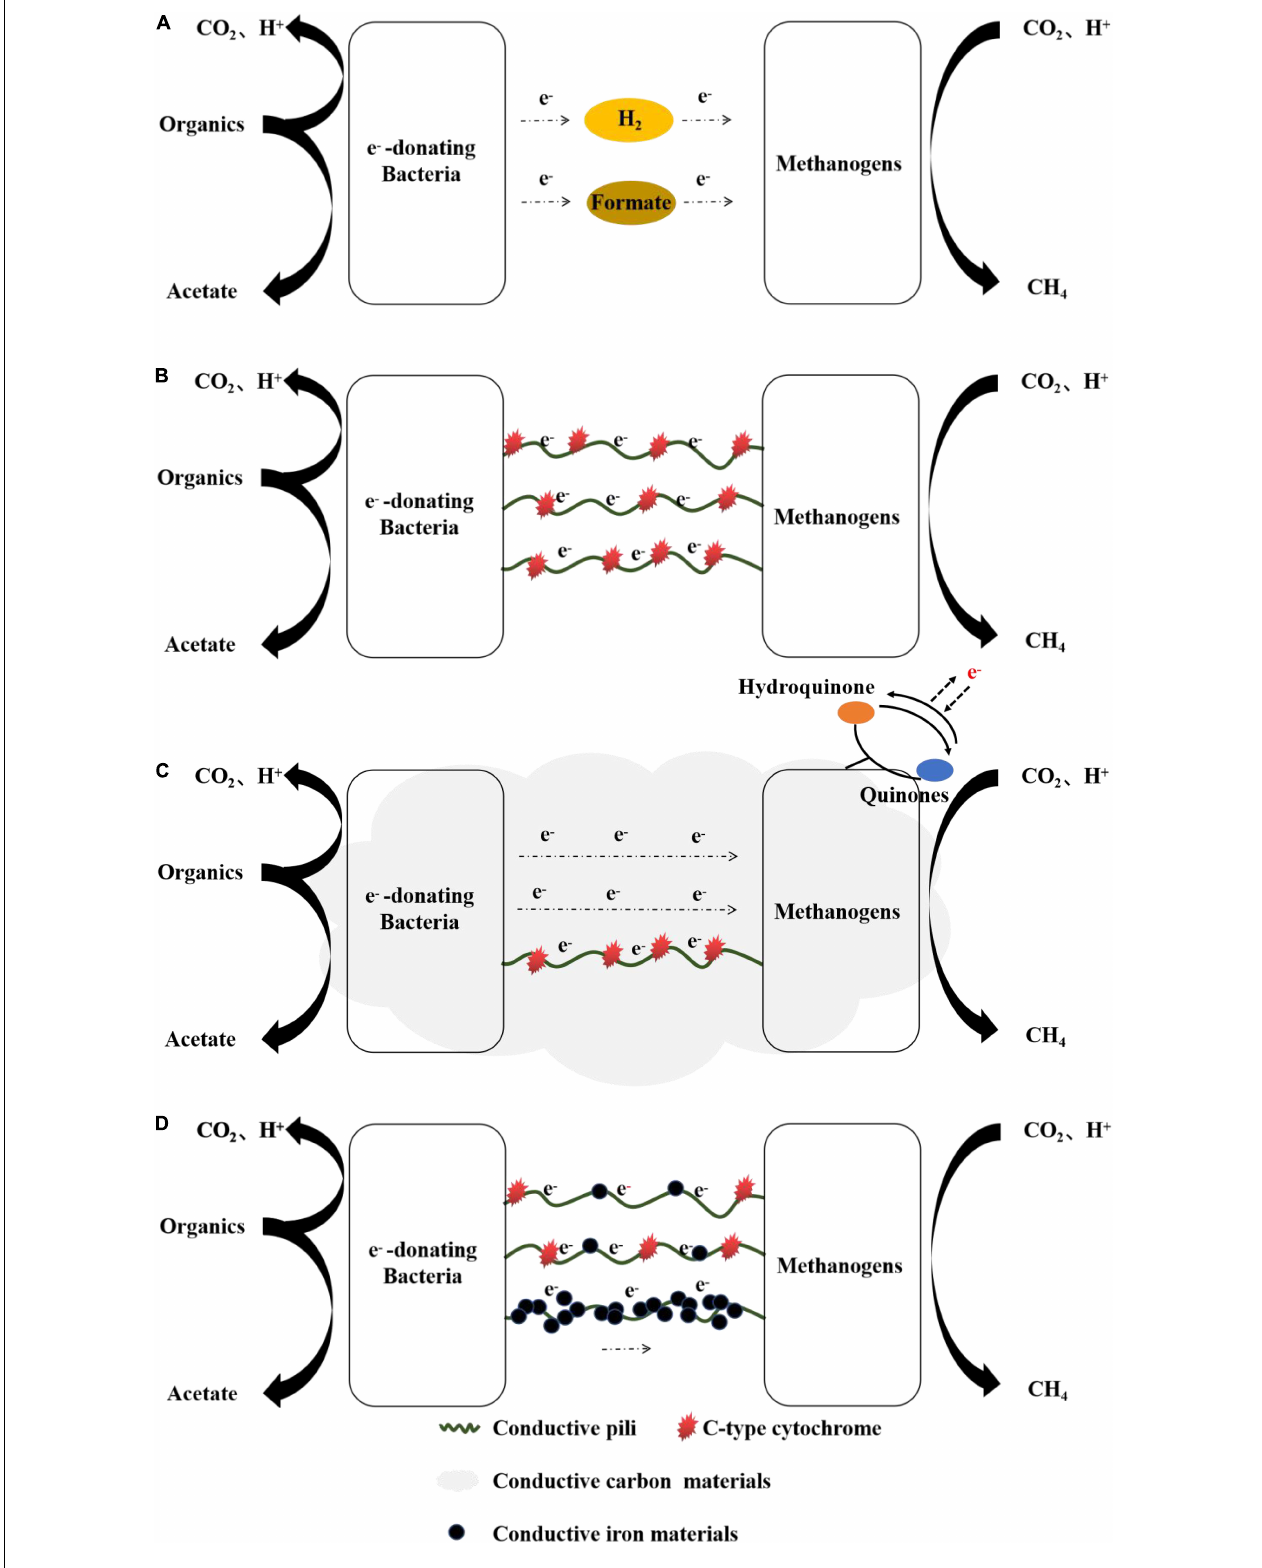
FIGURE 2 | Electron transfer mechanisms (A) IHT and IFT, (B) biological structure mediating DIET, (C) conductive carbon material mediating DIET, and (D) conductive iron material mediating DIET.